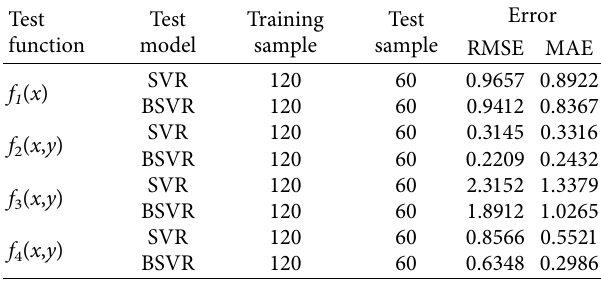
Table 1: Error comparison between BSVR and